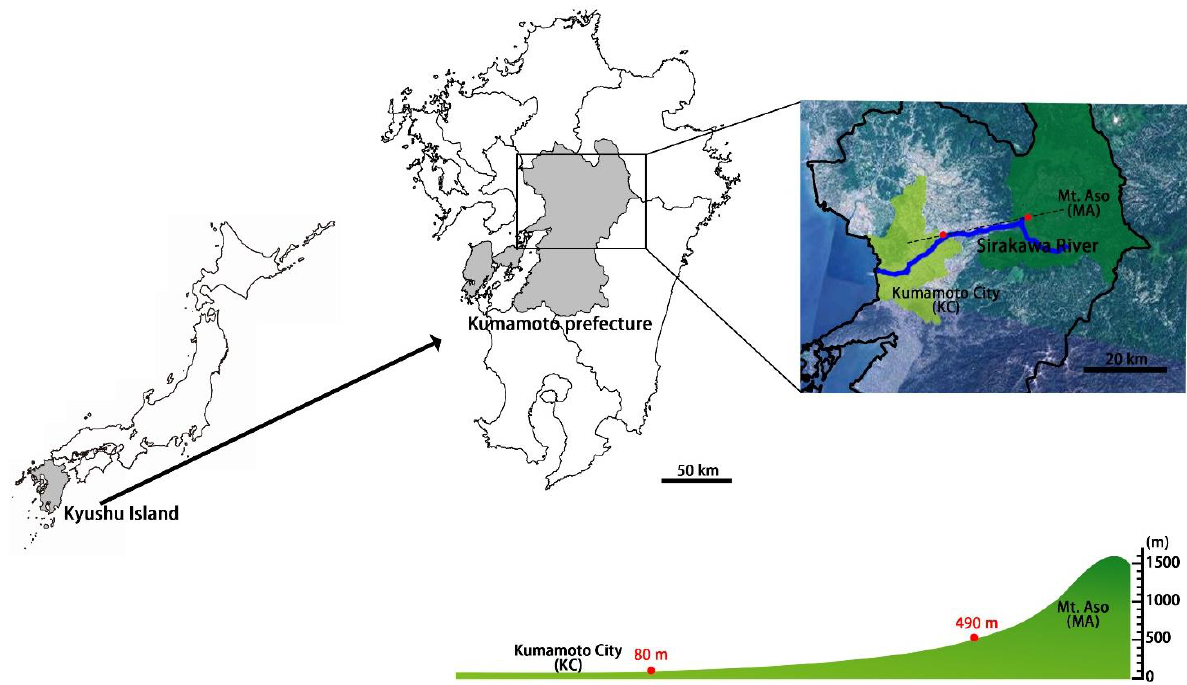
Figure 1. Locations and altitudes of the study sites at Mount Aso (Aso Campus of Tokai University) and Kumamoto City (Musashi-zuka), Kumamoto Prefecture, Japan. Source of the map: Digital map (Kashmir) of Geographical Survey Institute